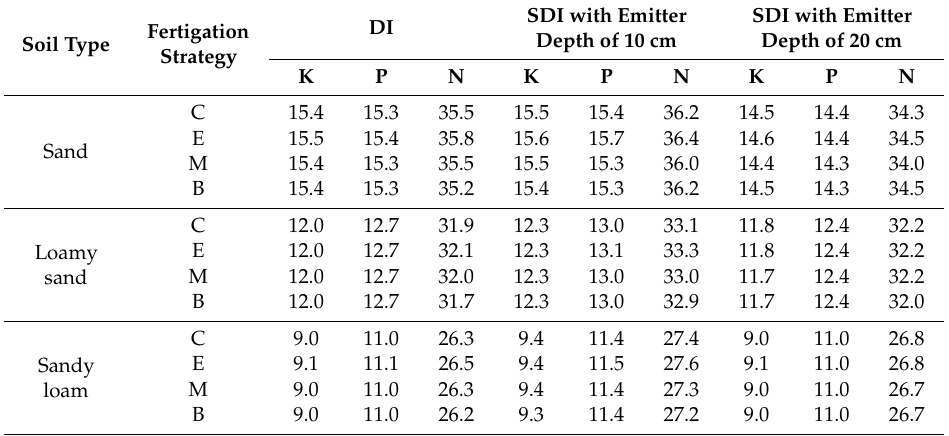
Table 6. Percentage of root uptake for potassium, phosphorus, and nitrogen as a fraction of the total potassium, phosphorus, and nitrogen added, respectively, for di ff erent fertigation